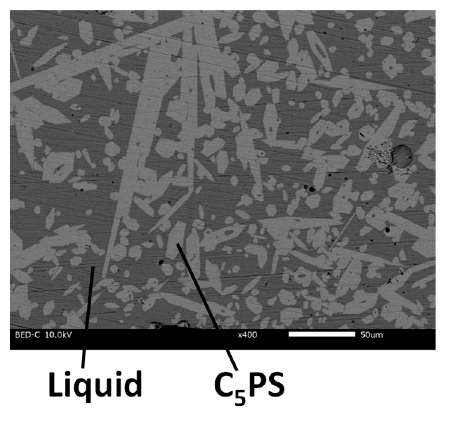
Figure 7. SEM image of M3-A5 (5mass% Al 2 O 3 ) ( left ) and the phase composition projected on an isothermal section of the CaO-SiO 2 -P 2 O 5 ternary phase diagram at 1573 K ( right ).